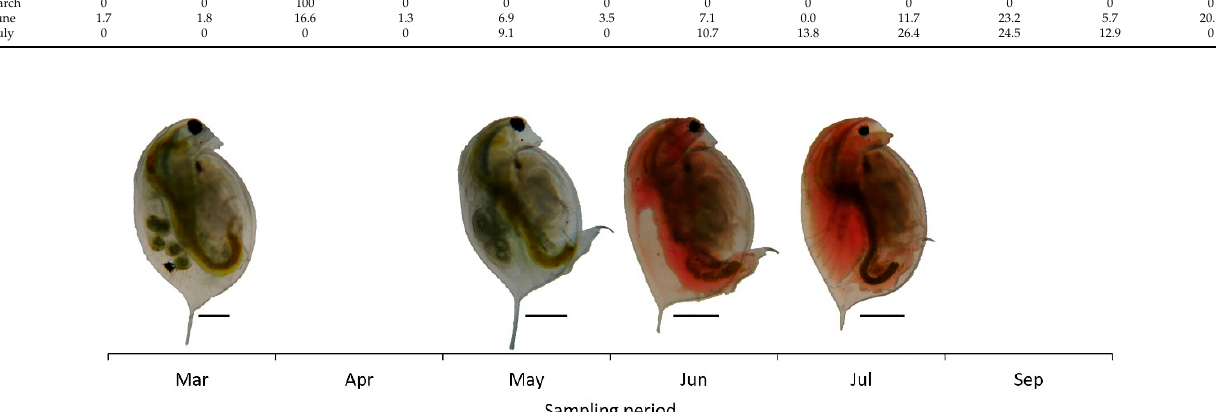
Figure 3. Microphotographs of individuals of Daphnia magna showing color variation during the study period. In May, Daphnia individuals were present only in the qualitative samples due to maximum sampling effort (scale bar: 0.5 mm). Table 2. Contribution (%) of the body size ( μ m) of Daphnia magna (females (F) and males (M)) during the study period. Size ( μ m) 701–900 901–1100